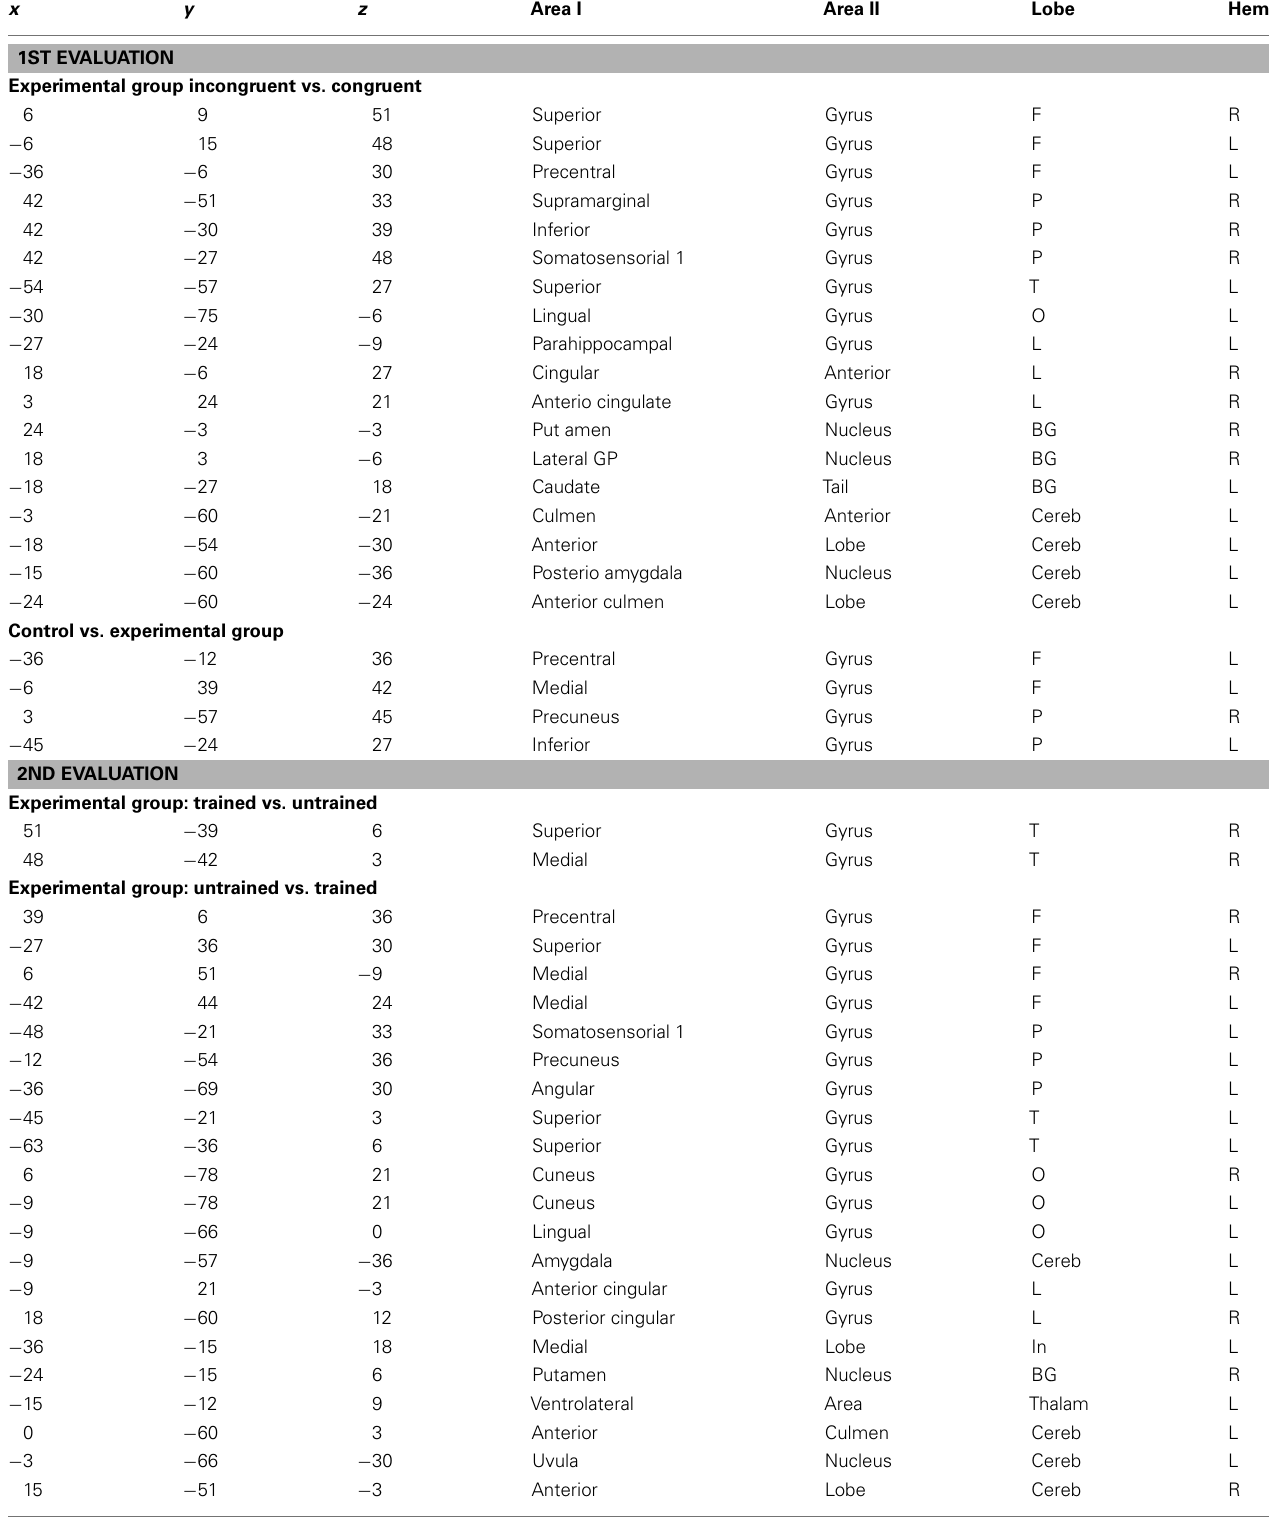
Table 3 |Activation related to the training condition in controls and trained or untrained PD patients during the Stroop test in both the first and second evaluation ( p =